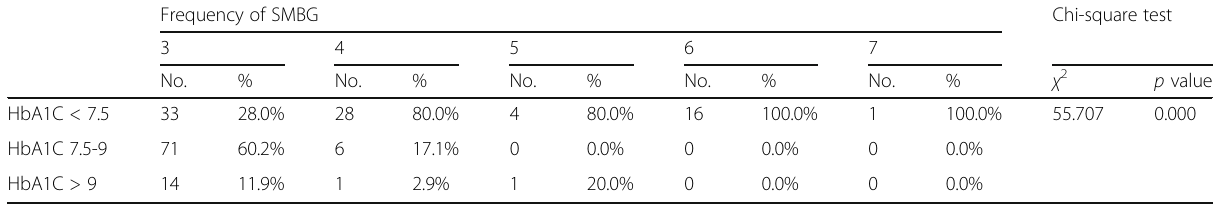
Table 2 Correlation between frequency of SMBG and HA1C Frequency of SMBG Chi-square